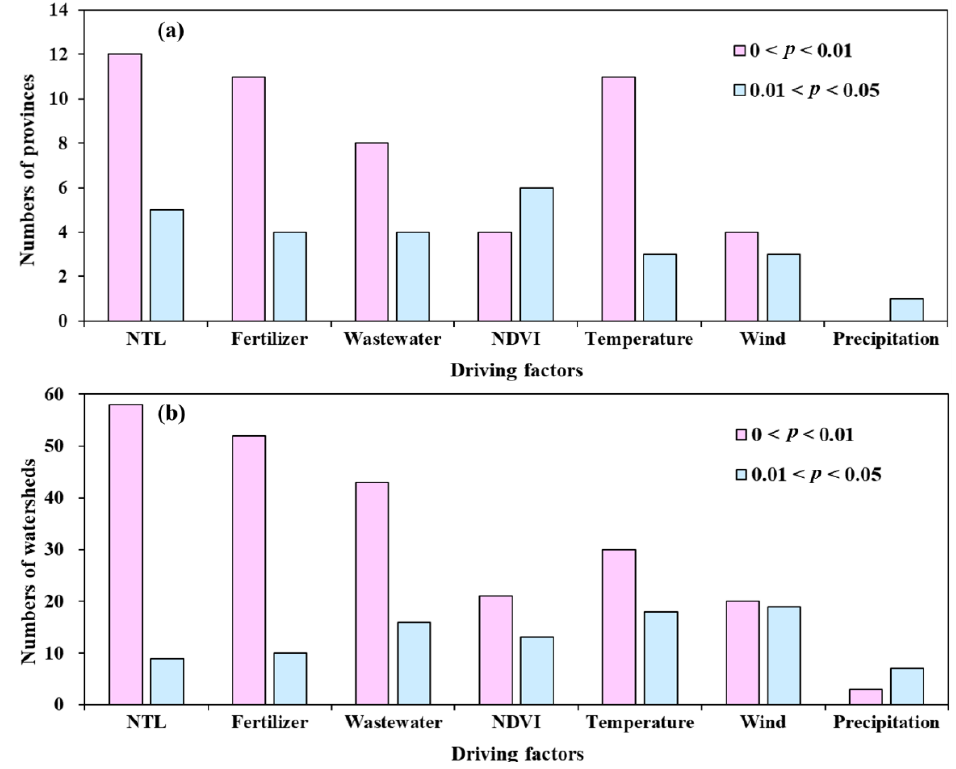
Figure 4. Histograms showing the number of provinces ( a ) or watersheds ( b ) where each of the listed natural and socio-economic driving factors had a significant effect on SDD. Histograms are shown for analysis conducted at the 5% and 1% significance levels.